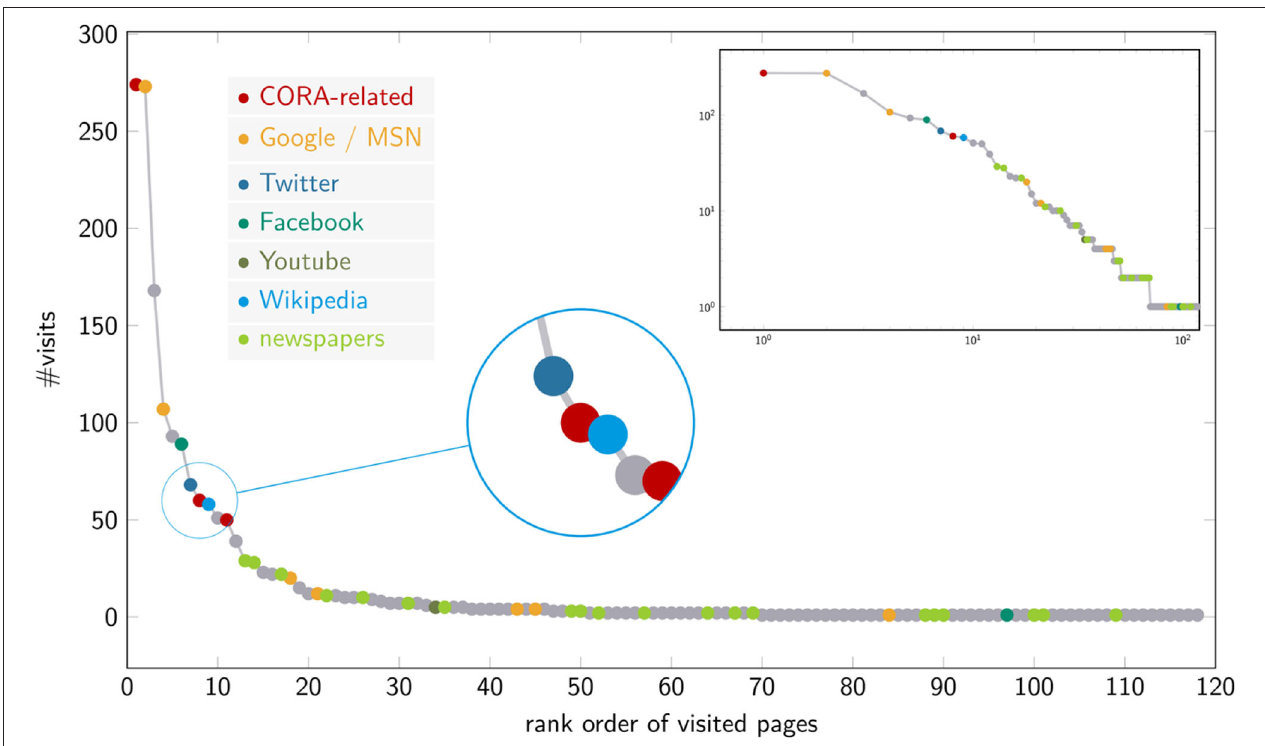
FIGURE 4 | Rank-frequency distribution of accesses to web resources in the CORA project. The embedded figure shows the frequency distribution as a log-log